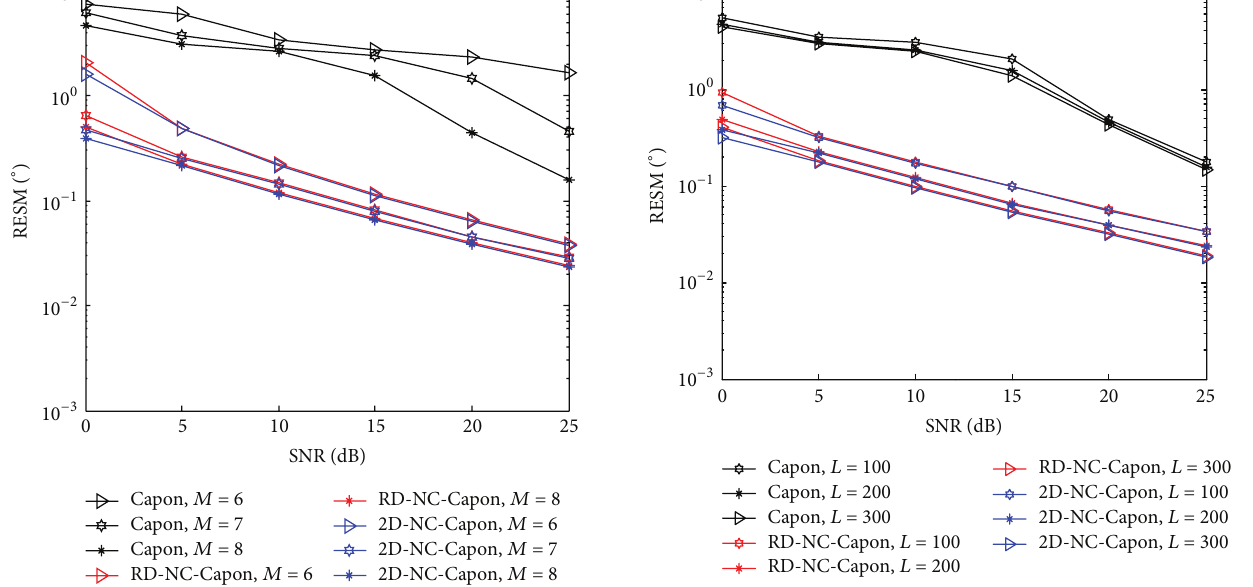
Figure 9: The DOA estimation performance with different number of snapshots ( 𝑀 = 8 and 𝐾 = 3 ).